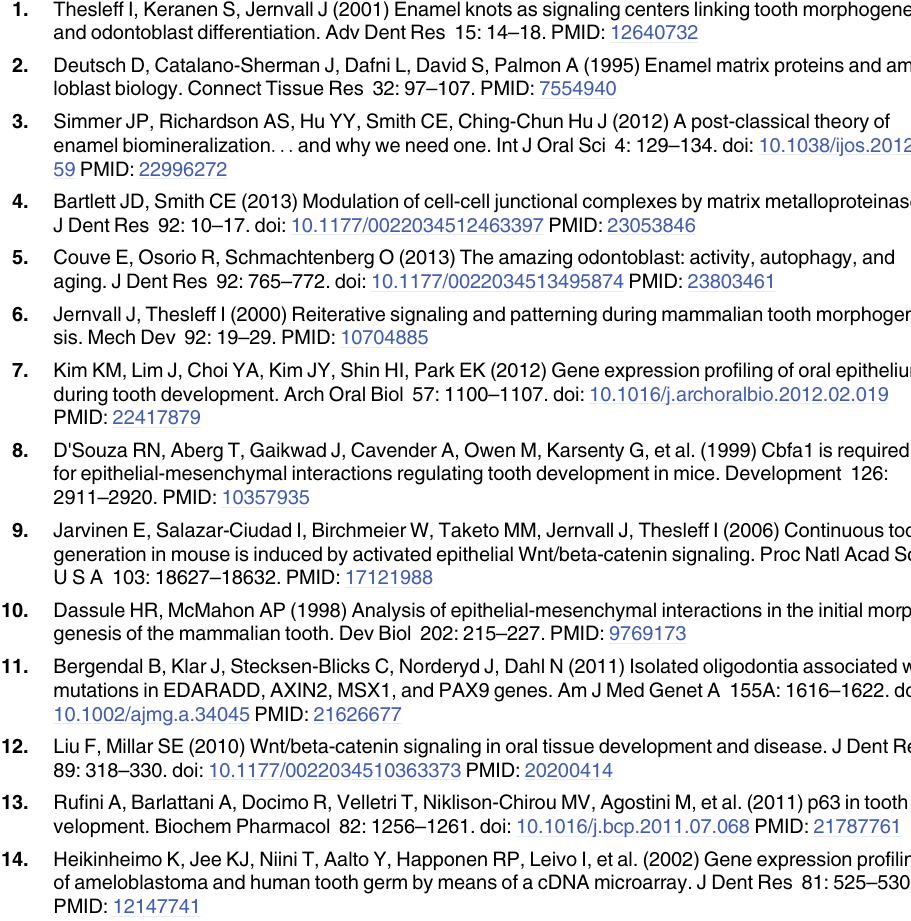
S2 Table. Top 20 differentially expressed canonical pathways between odontoblasts and pre-secretory ameloblasts. S3 Table. Top 20 different upstream regulators between odontoblasts and pre-secretory